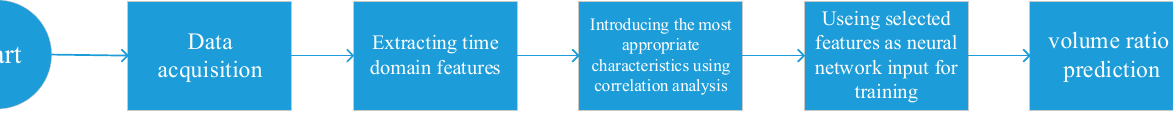
Figure 10. The process algorithm for predicting volume ratio.